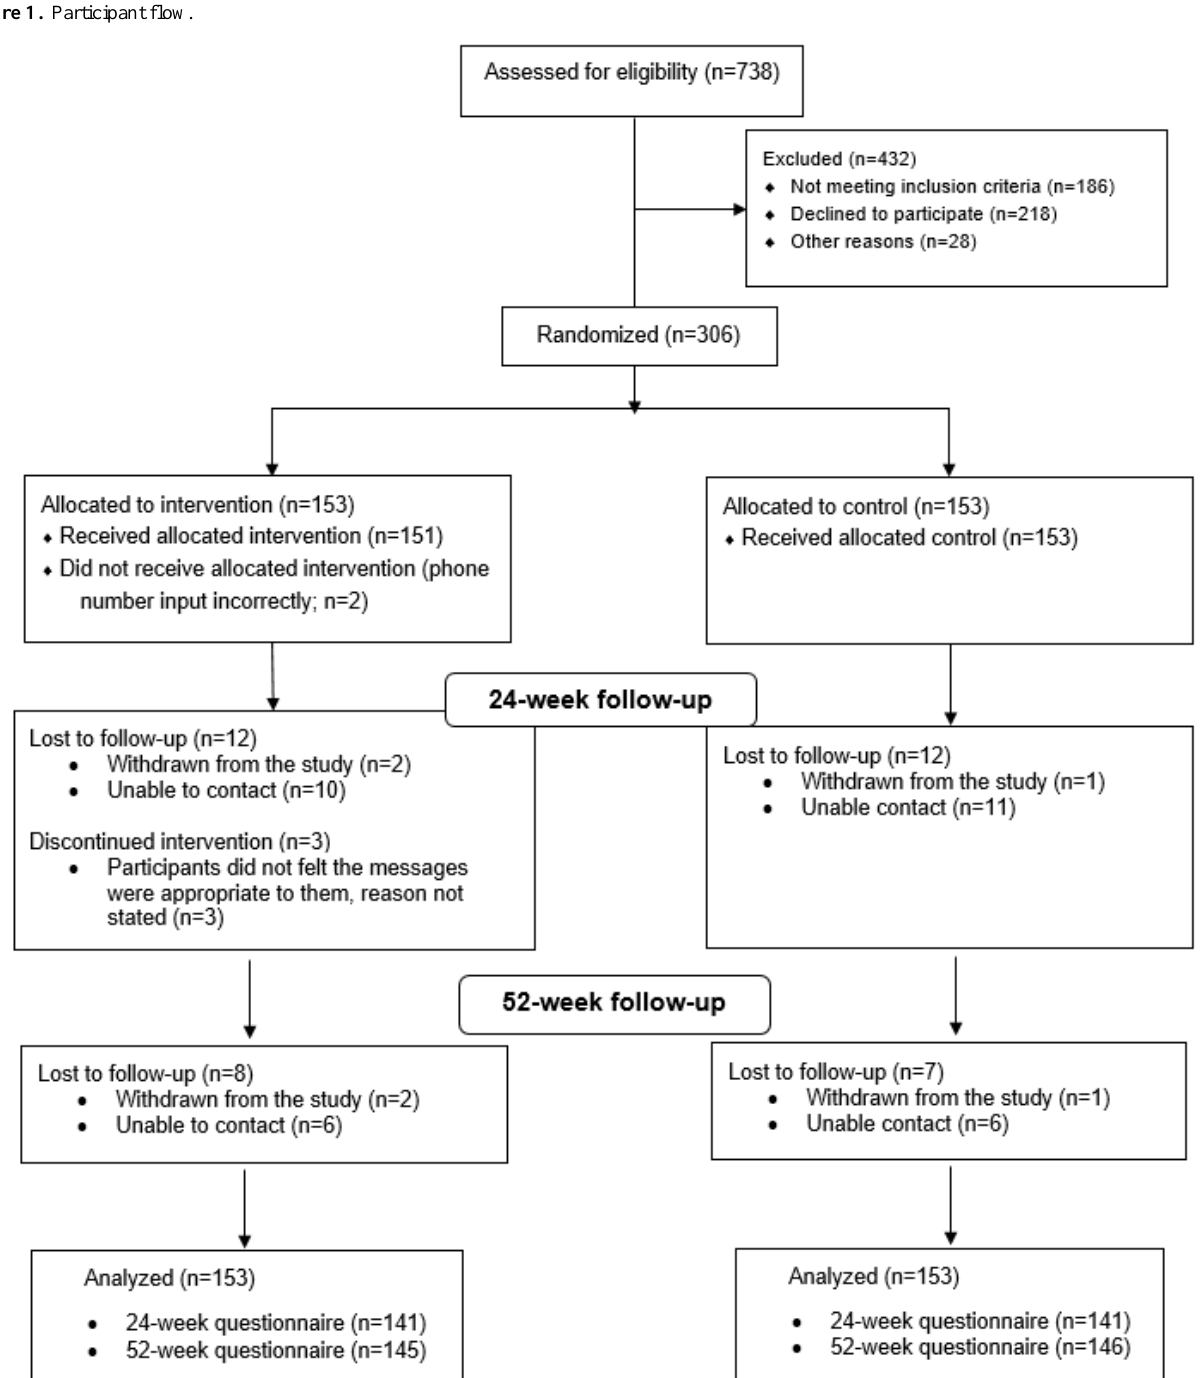
Figure 1. Participant flow.